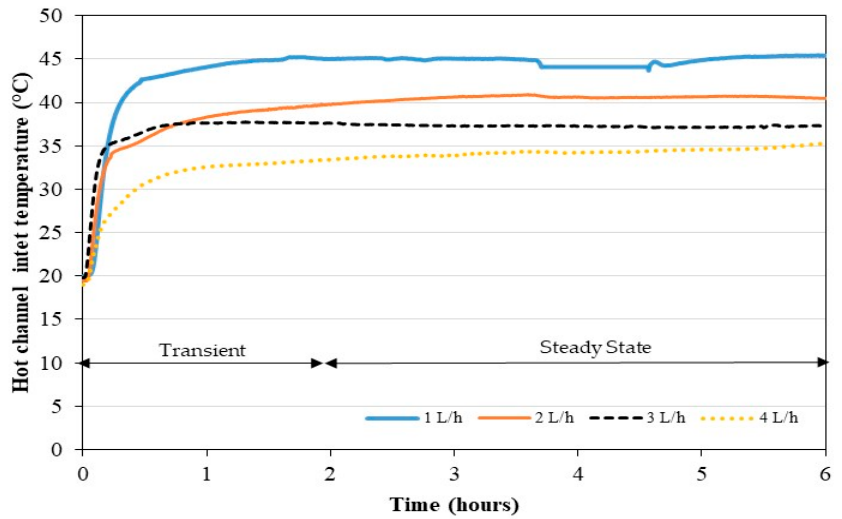
Figure 9. Effect of the flow rate on the water inlet temperature in the hot channel in continuous mode.